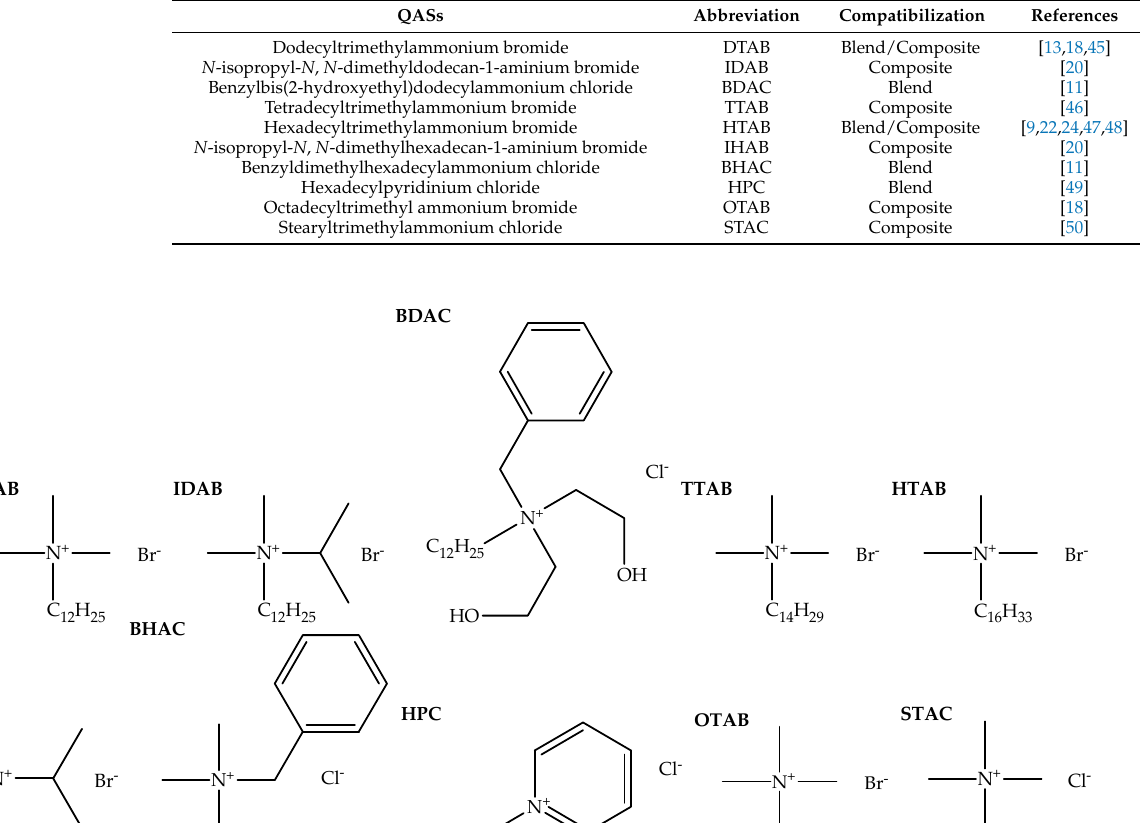
Table 6. Examples of quaternary ammonium ionic liquids (QAILs) applied for compatibilization of polymer blends and polymer composites.